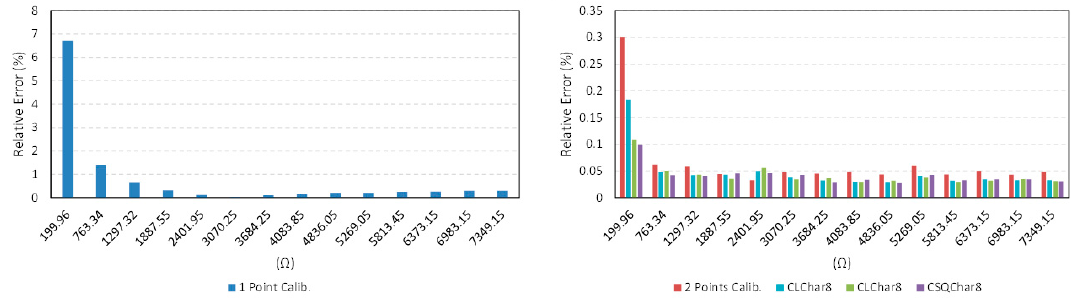
Figure 17. Relative error for the calibration techniques described in Sections 2.1 and 4.